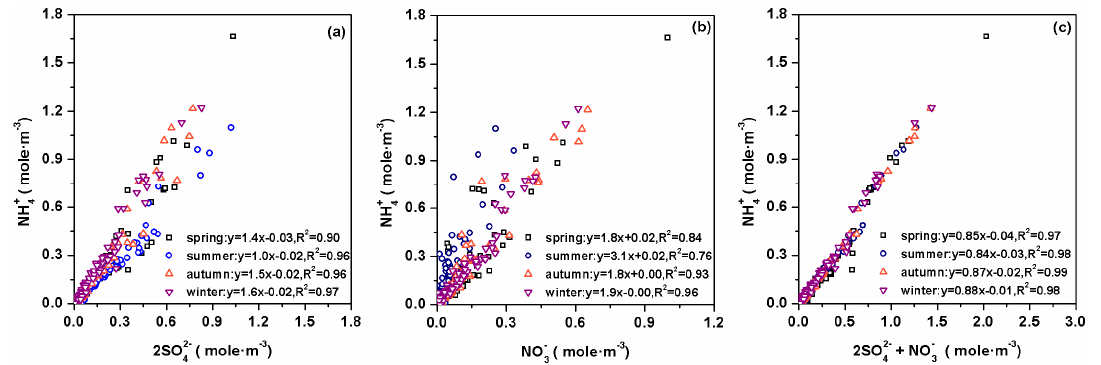
Figure 4. Scatter plots of NH 4+ vs. SO 42 − ( a ); NH 4+ vs. NO 3 − ( b ); and NH 4+ vs. SO 42 − plus NO 3 − ( c ) in four seasons.